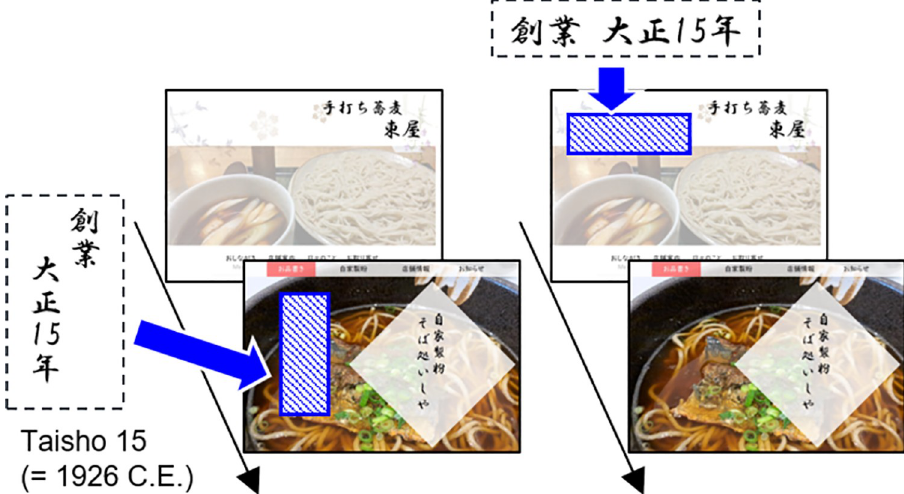
Fig 2. Schematic of a trial sequence from Experiment 1. The restaurant’s year of establishment was presented in a label in Japan’s Taisho 15 era date format (1926 C.E.). The label condition (present vs. absent) was counterbalanced across